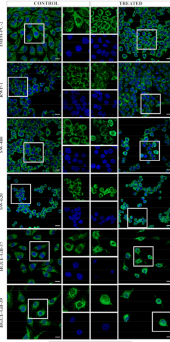
Figure 3. AIF translocation during CLytA-DAAO-induced cell death. IMIM-PC-2, RWP-1, SW-480, SW-620, HGUE-GB-37 and HGUE-GB-39 cell lines were untreated (C) and treated (T) with CLytA-DAAO and D-Ala for 6 h. Images show AIF (green) and 4 (cid:48) ,6-diamidino-2-phenylindole (DAPI) (blue) staining. Central images display an amplification of the white box. Scale bar, 20 µ